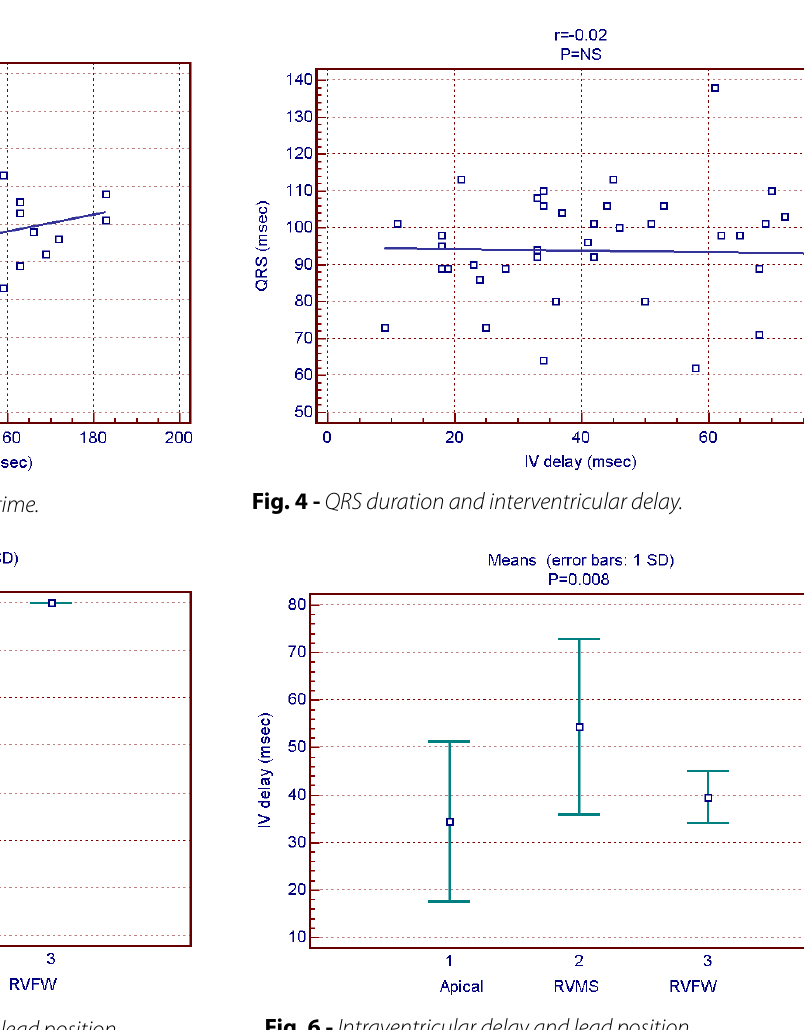
Fig. 5 - New York Heart Association class and lead position. NYHA=New York Heart Association; RVFW=right ventricle free wall; RVMS=right ventricle medium septum